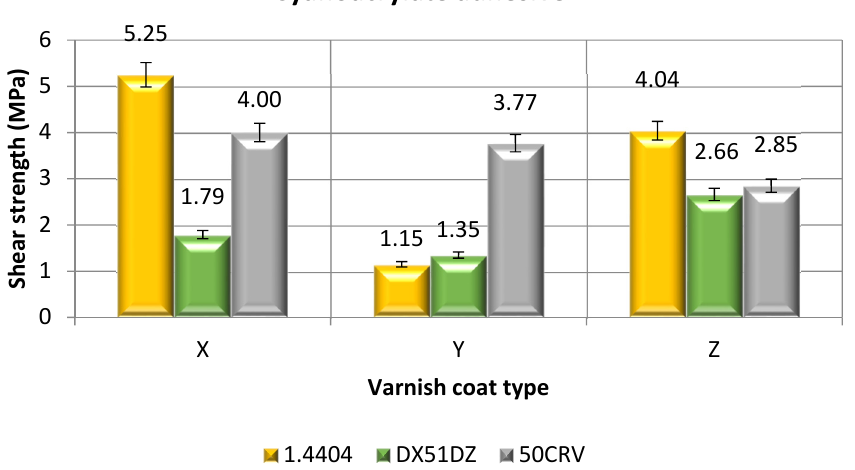
Figure 5. Shear strength of adhesive joints for samples with varnish coats, made with cyanoacrylate adhesive.